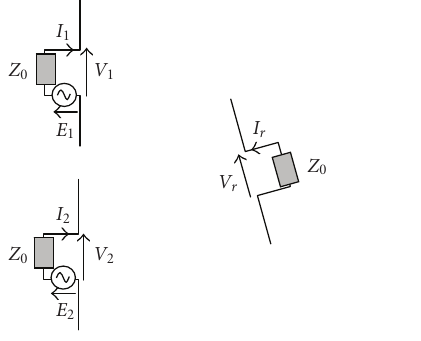
Figure 1: Multiple antennas operating in transmission.